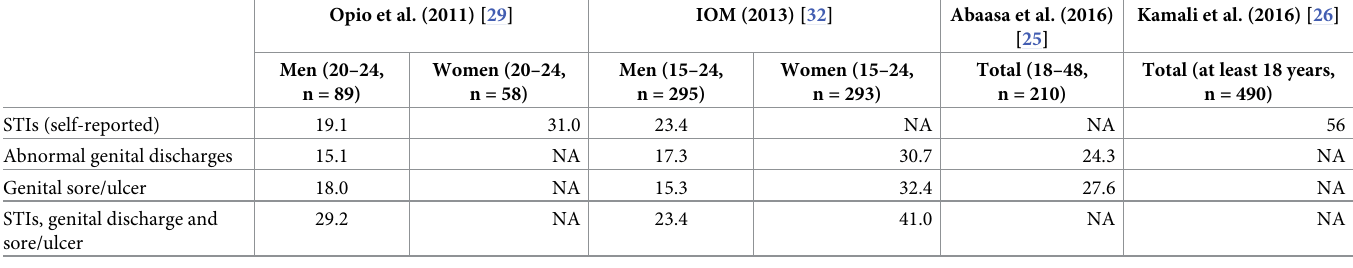
Table 3. Percentage of self-reported history of STIs, abnormal genital discharges and sore/ulcer in the past 12 months among fishing communities. Opio et al. (2011) [29] IOM (2013) [32] Abaasa et al. (2016)